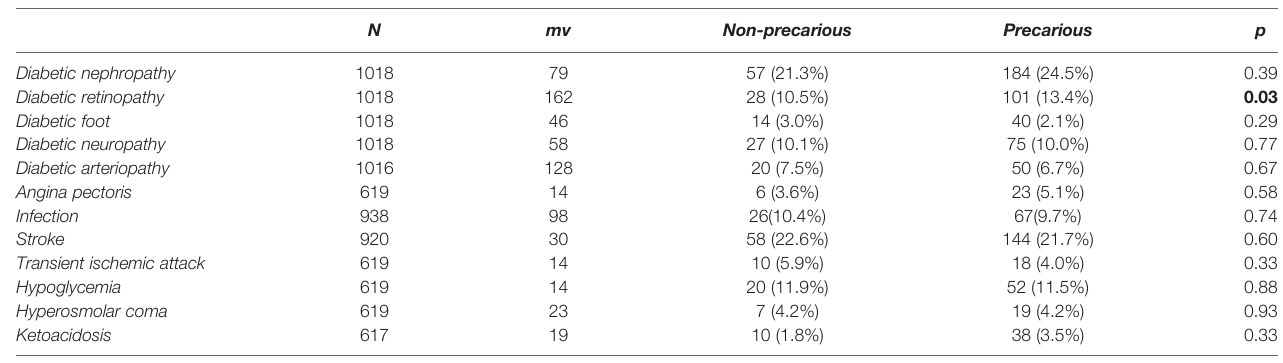
TABLE 3 | Complications of the patient with diabetes according to